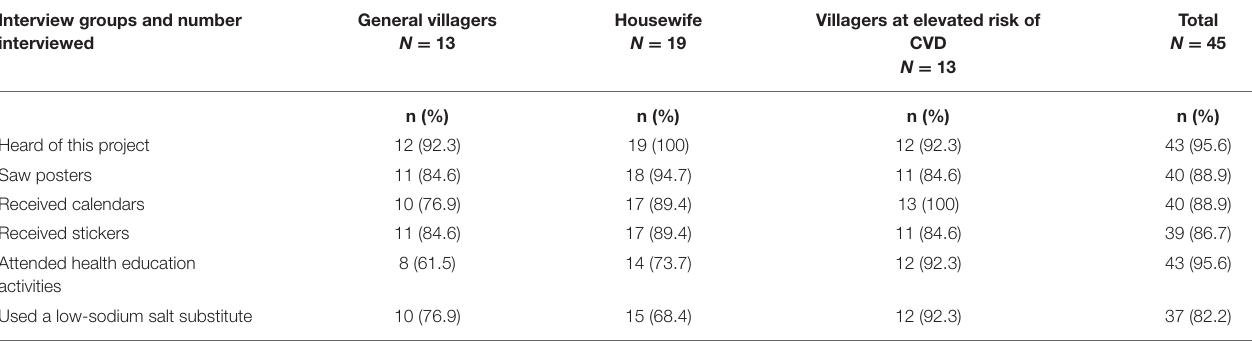
TABLE 3 | Reach of each component that interviewees exposed to the intervention. Interview groups and number